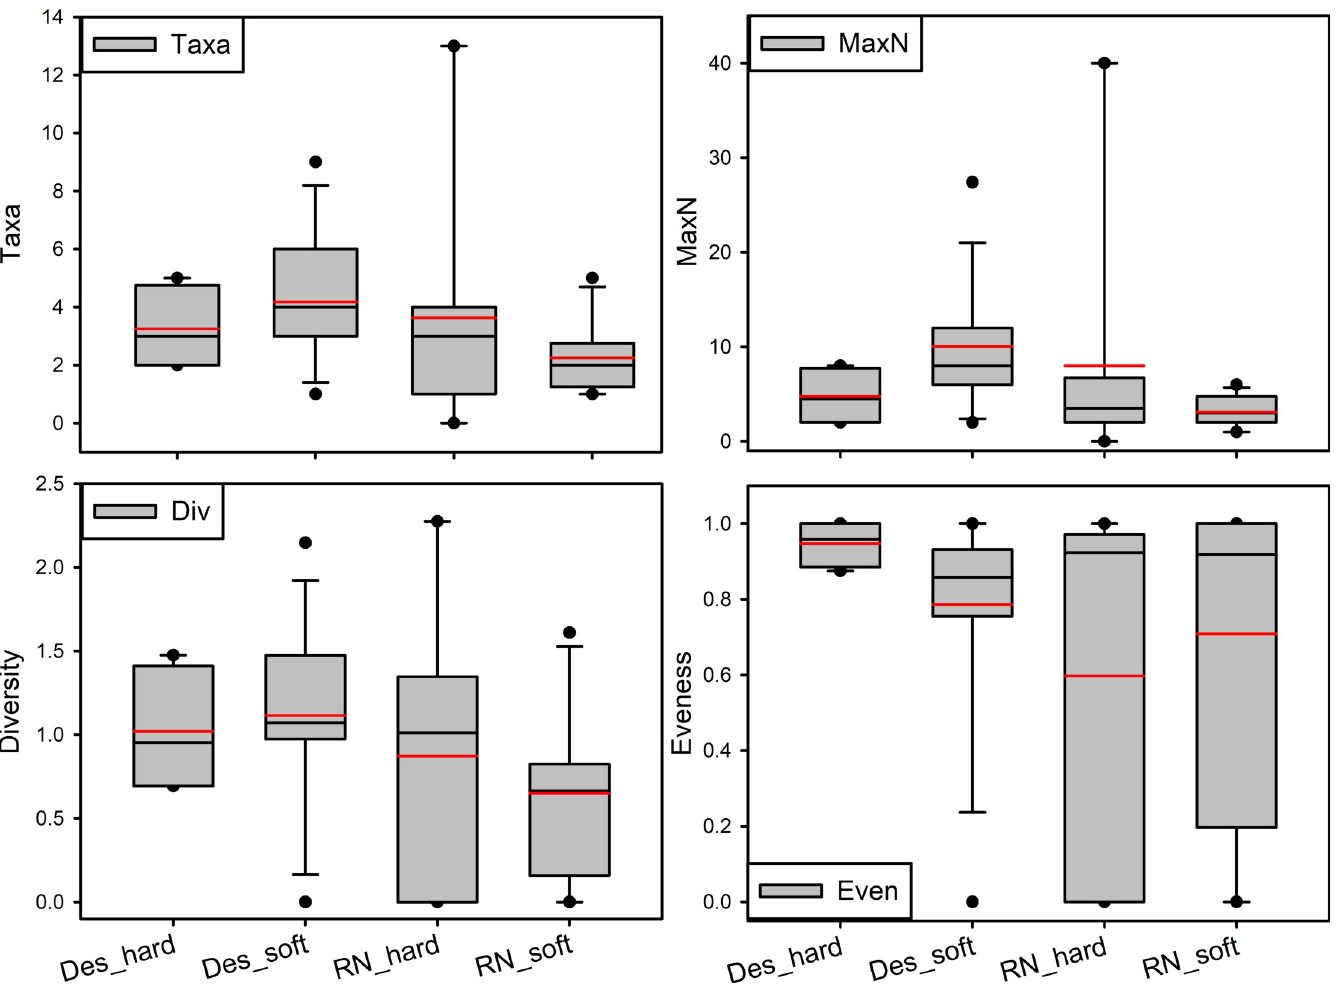
Fig 8. Fish assemblage characteristics (taxa richness, MaxN, diversity, and evenness) at Desventuradas and RN/SyG on hard and soft-bottom habitats. Box plots showing median (black line), mean (red line), upper and lower quartiles, and 5th and 95th